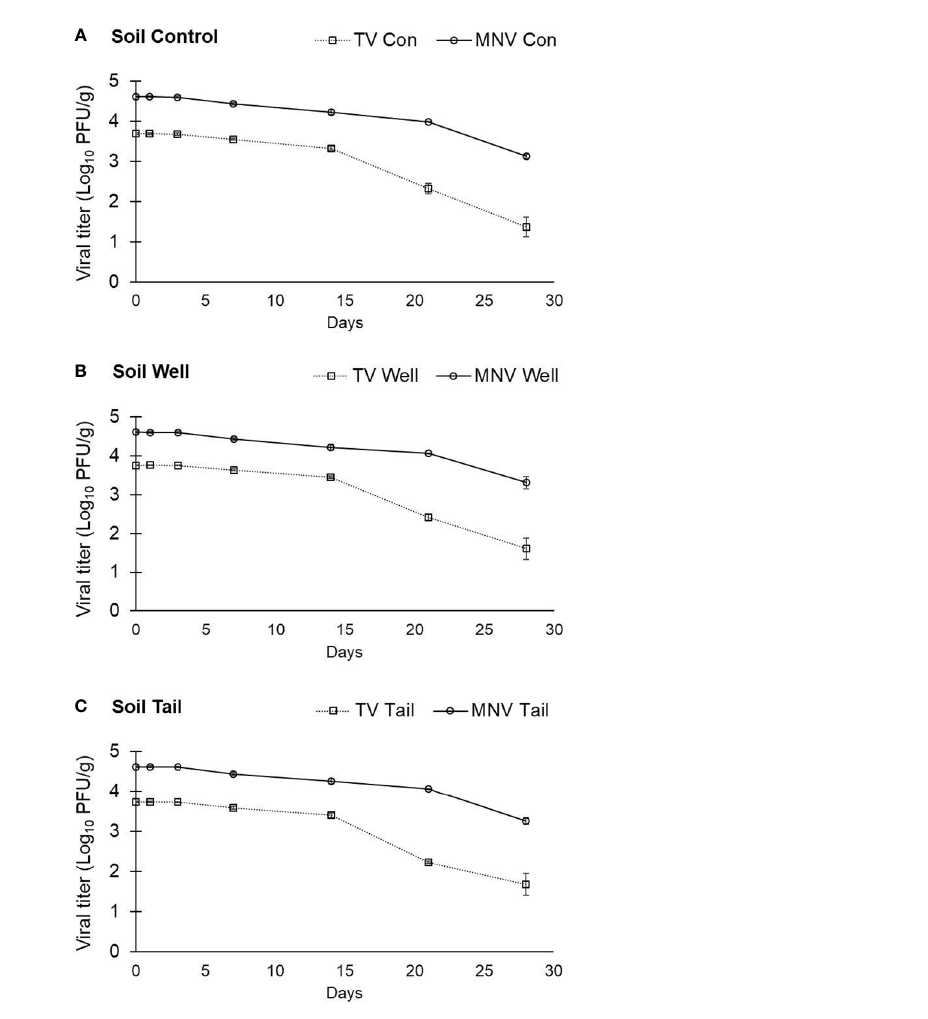
FIGURE 3 Infectivity of TV and MNV in sandy loam soil over a 28-day period. TV or MNV were suspended in (A) ultrapure water (control), (B) well water, and (C) tail water and the suspensions were separately mixed uniformly into soil. Viral titer is reported as PFU/g. Data points are the average of six replicates. Error bars represent ± standard